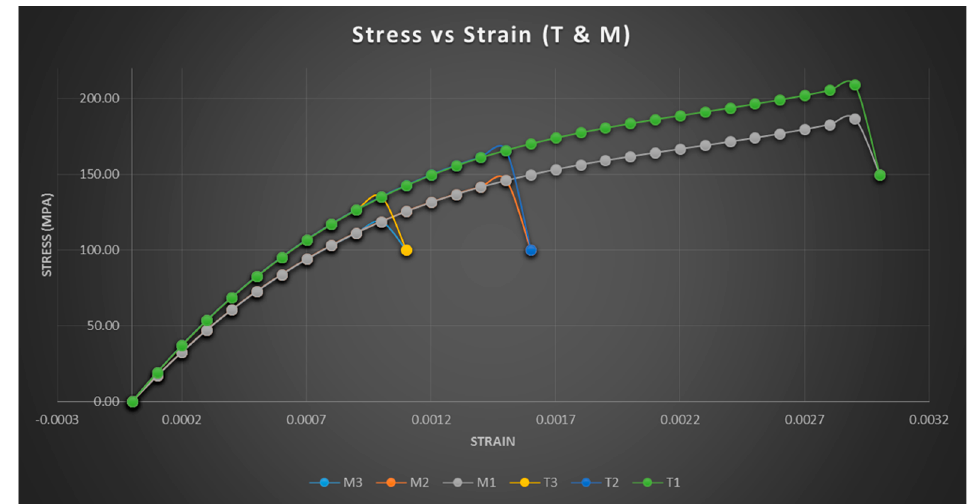
Figure 11. Comparison of the stress–strain curve for types T and M.